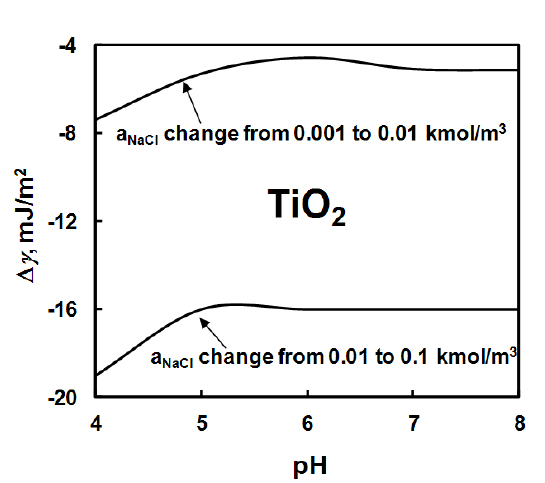
Figure 3. Change of interfacial excess energy of TiO activity change at a constant pH. pHpzc = 6.0.